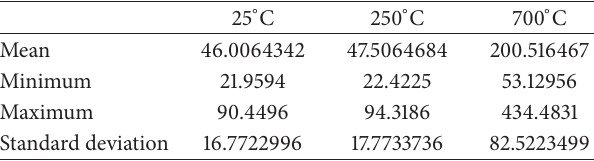
Table1:Mean,minimum,maximum,andstandarddeviationvalues after heating at different